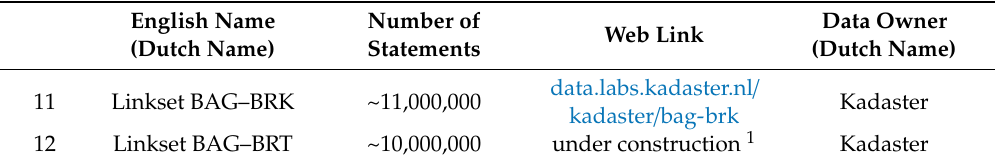
Table 4. Linksets within KKG that link three base registers, namely, BAG, BRT, and BRK. (Source: authors).